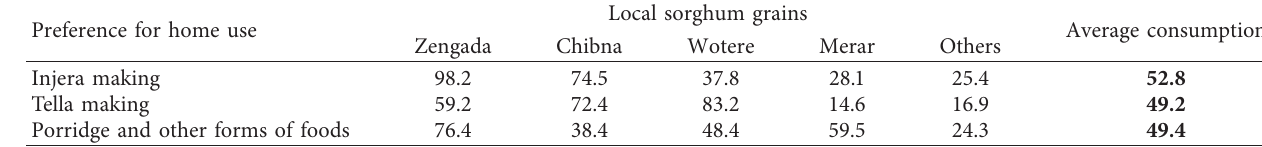
Source: local farmers during survey time, 2015/2016.